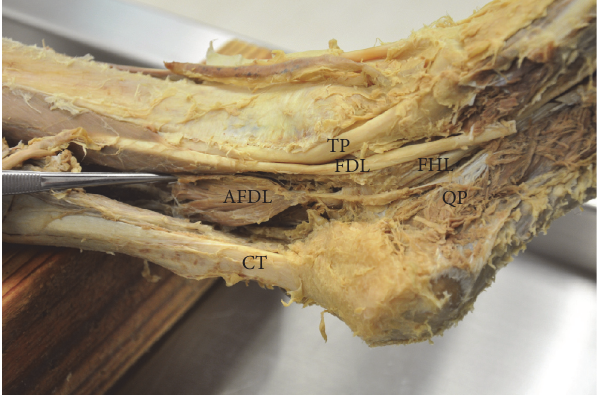
Figure 2: Dissection of left leg and foot to show accessory flexor digitorum longus muscle (AFDL: accessory flexor digitorum longus muscle; CT: calcaneal tendon; FDL: flexor digitorum longus tendon; FHL: flexor hallucis longus tendon; TP: tibialis posterior tendon; QP: quadratus plantae